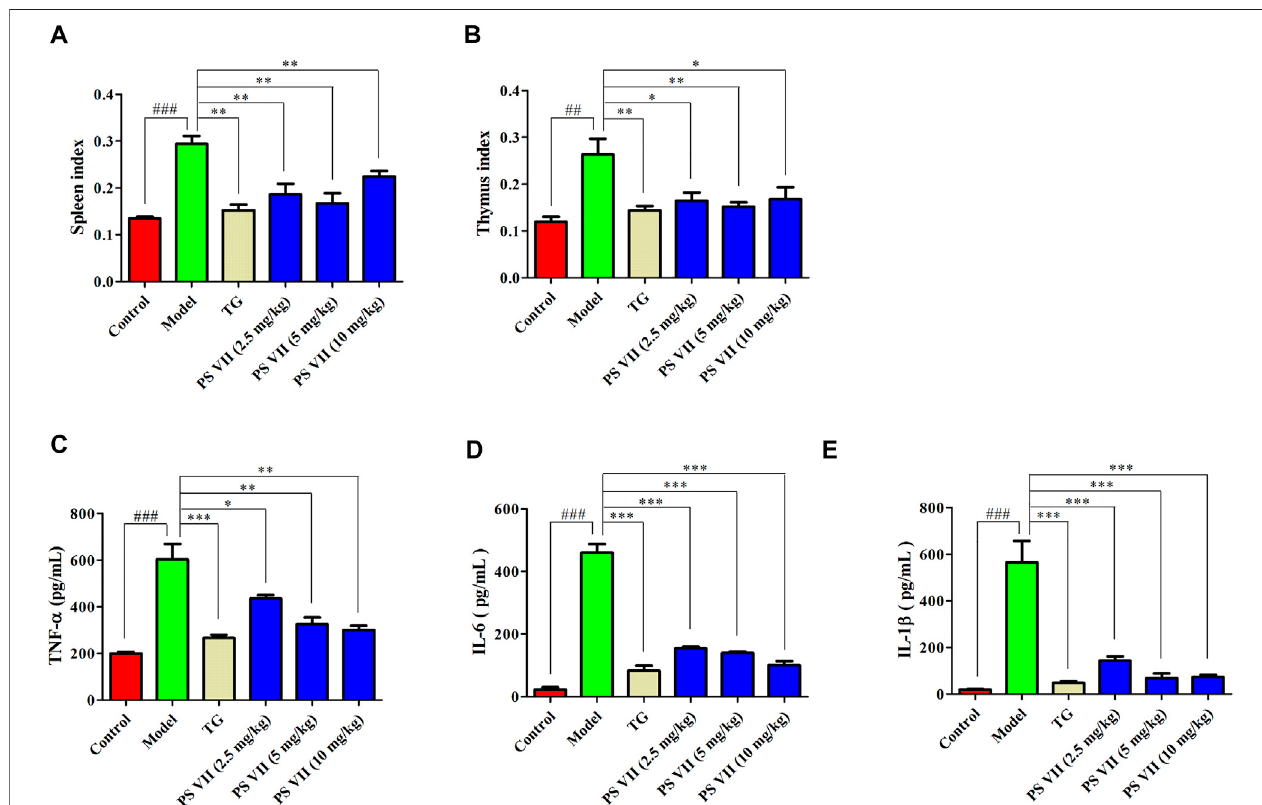
FIGURE10| EffectsofPSVIIonthespleen,thymusindexandserumlevelsofin fl ammatorycytokines. (A) Spleenindex. (B) Thymusindex.TheproductionofTNF- α (C) , IL-6 (D) , and IL-1 β (E) inthe serum ofAIA rats. Data were expressedasmean ± SD, n (cid:2) 5.Comparedwiththe controlgroup, # p < 0.05, ## p < 0.01, comparedwiththe model group, * p < 0.05, ** p < 0.01, *** p <